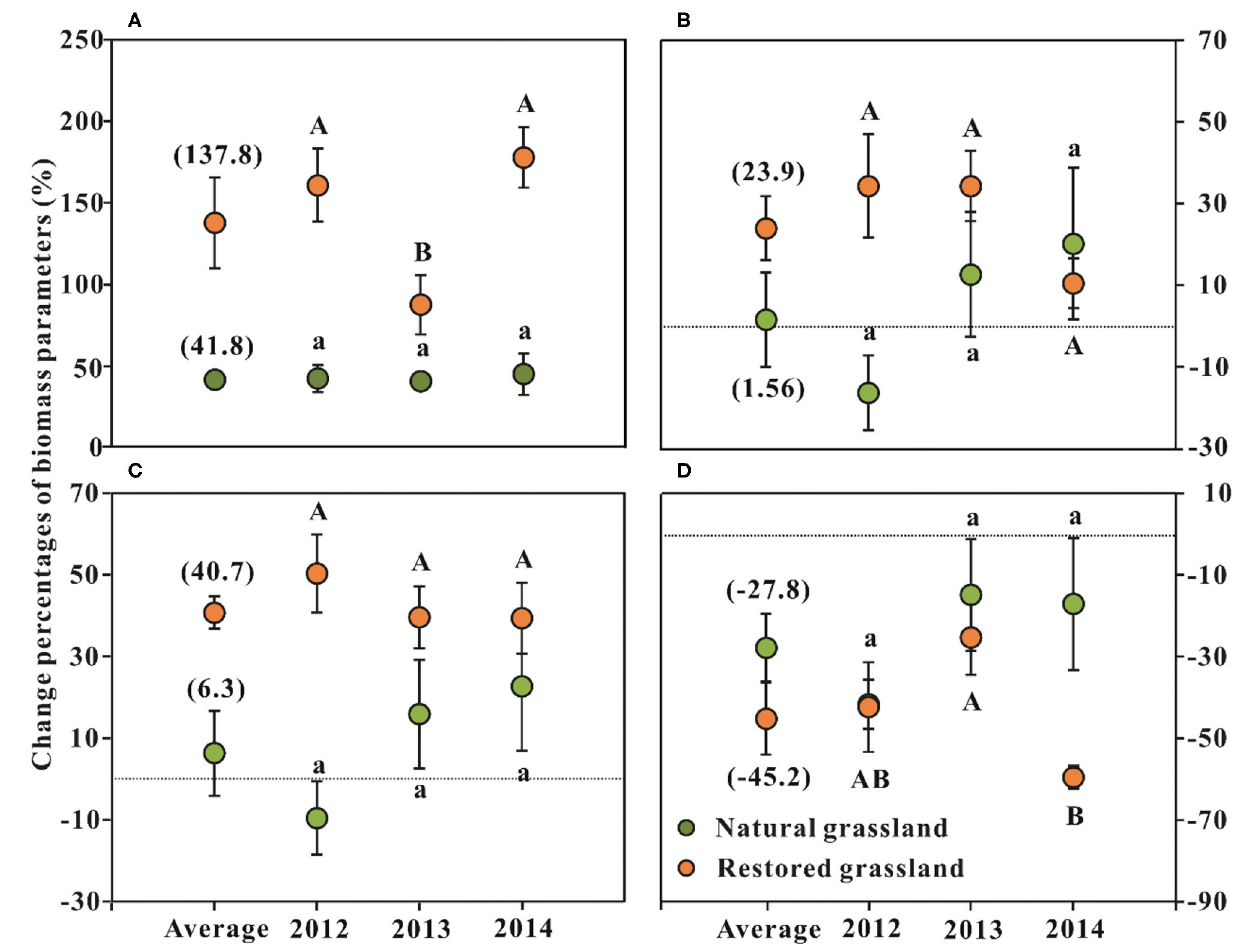
FIGURE 1 | Effects of nitrogen addition on the changes in plant community biomass parameters (mean ± SE, n = 6) in the alpine grasslands around Qinghai Lake Basin. (A) Aboveground biomass; (B) belowground biomass; (C) total biomass; (D) R/S ratio. R/S = The ratio of root (below-) and shoot (aboveground) biomass; Average represents the average effect across the three sampling years (mean ± SE, n = 18). Different lowercase letters indicate significant differences among sampling years in the natural grassland at p < 0.05, and uppercase letters indicate significant differences between sampling years in the restored grassland at p < 0.05.